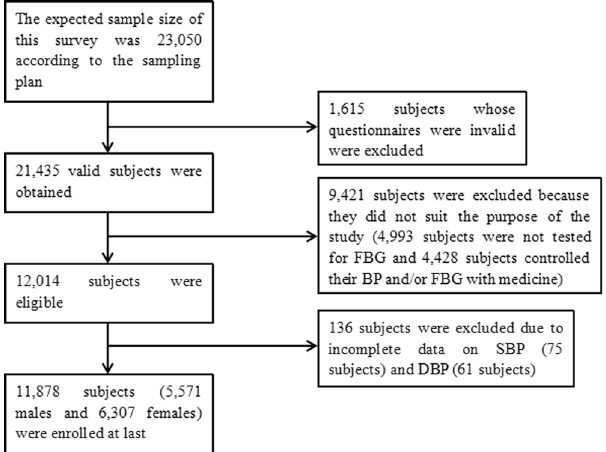
Figure 4. Flow diagram of the study design and participant selection process for this